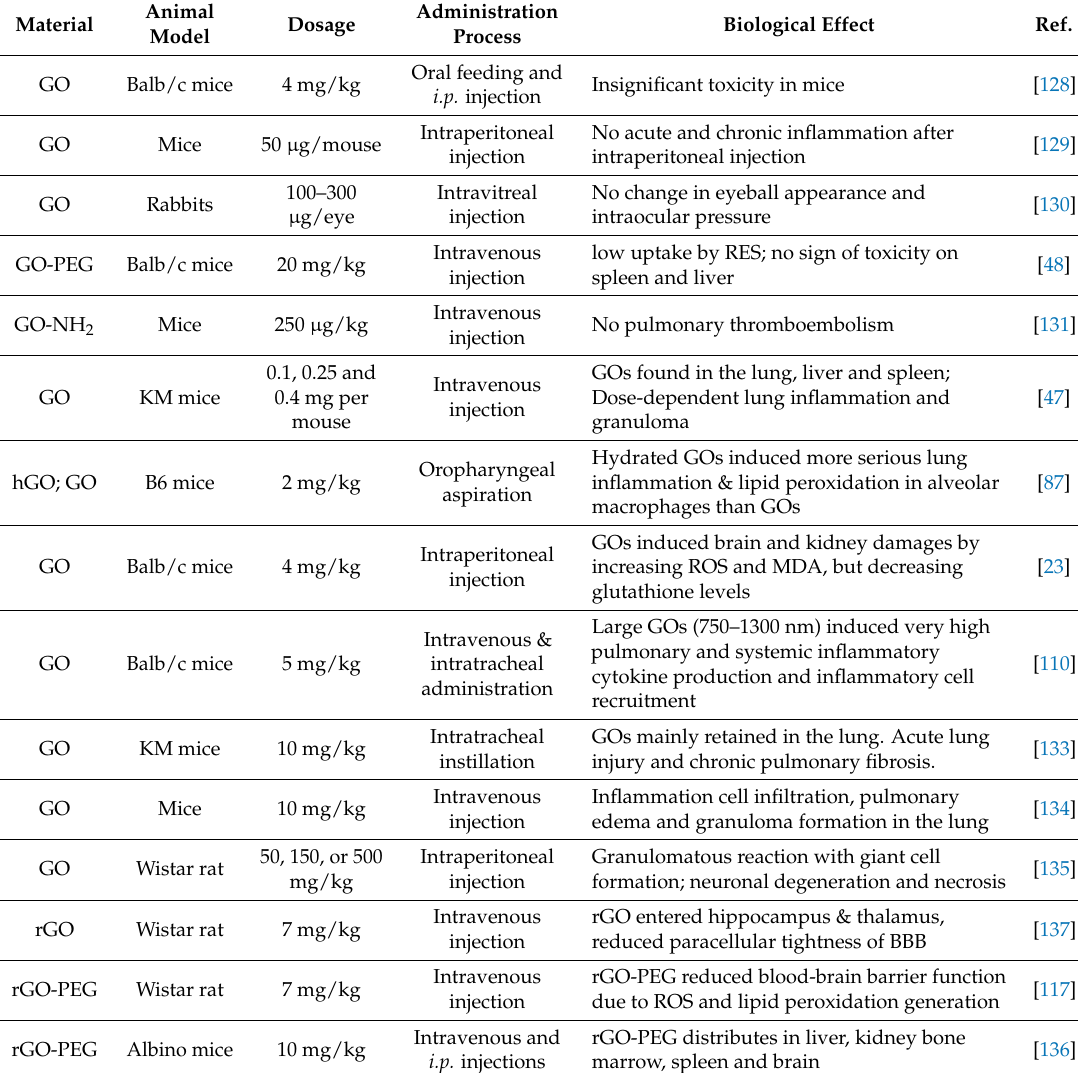
Table 2. In vivo studies showing different administration routes of GOs and functionalized GOs.